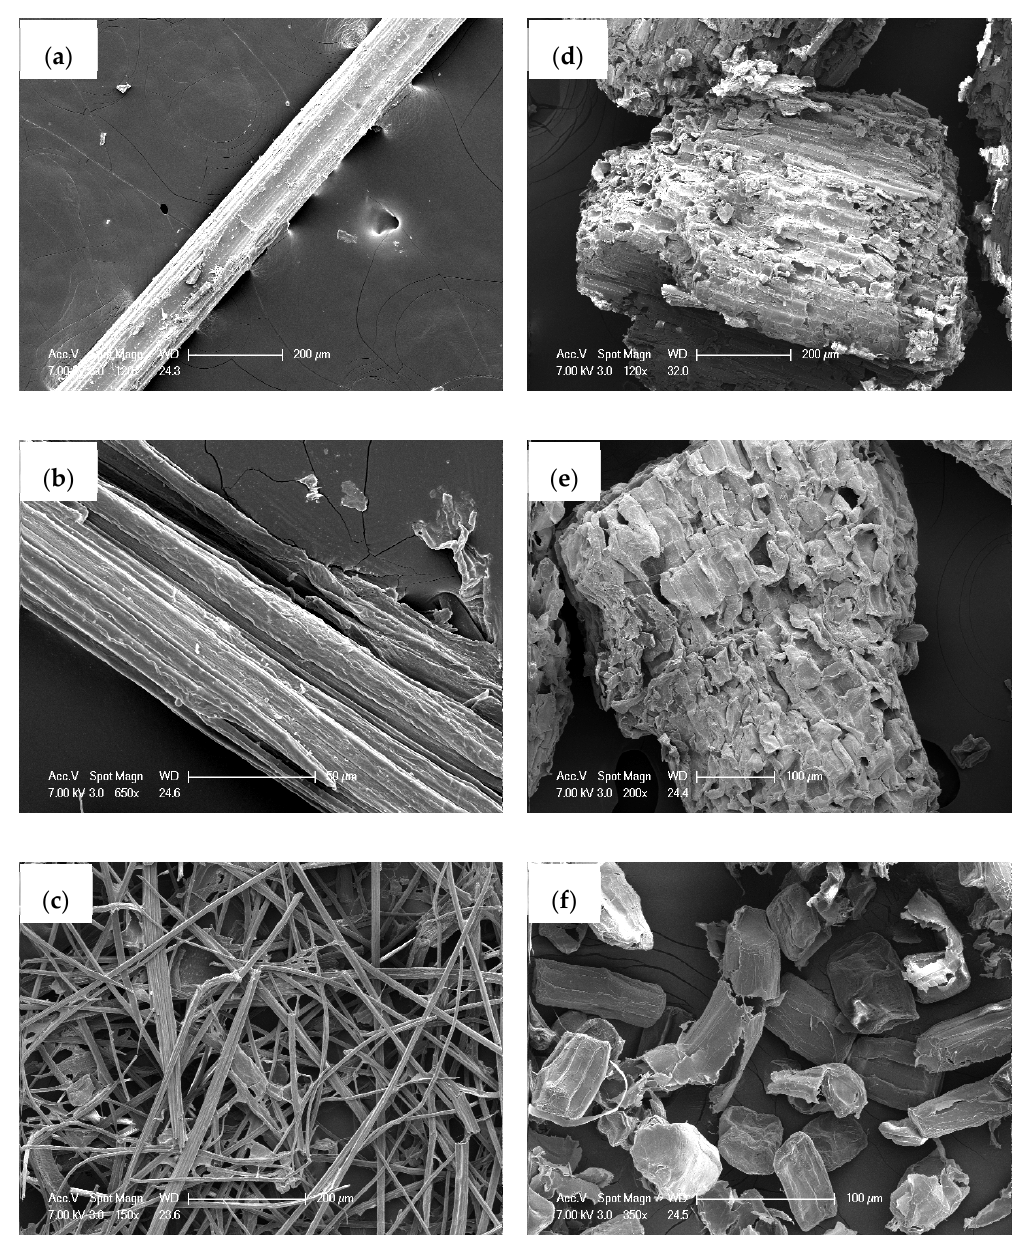
Figure 3. SEM images of fibers and parenchyma cells after chemical pretreatment. ( a – c ) F, F-LCSR and F-CSR, respectively; ( d – f ) P, P-LCSR, P-CSR, respectively.